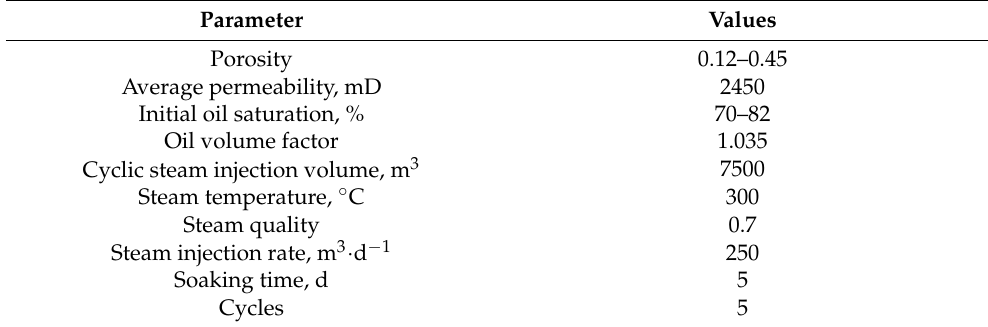
Table 5. Reservoir properties and operational parameters used in the simulation model.